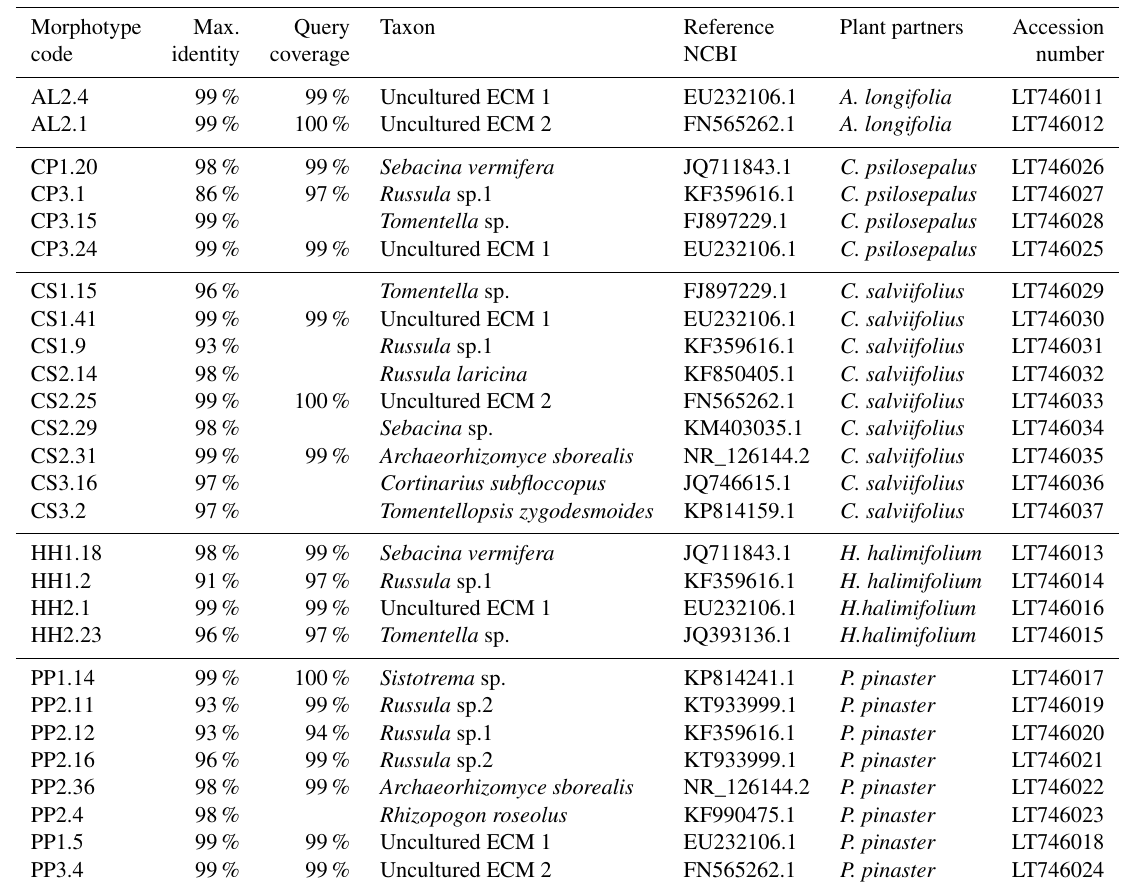
Table 2. Results from the BLAST analysis based on ITS sequences obtained from field-collected ECM root tips. The most similar sequences from NCBI are represented by their accession numbers. Species identification was done at sequence similarity higher than